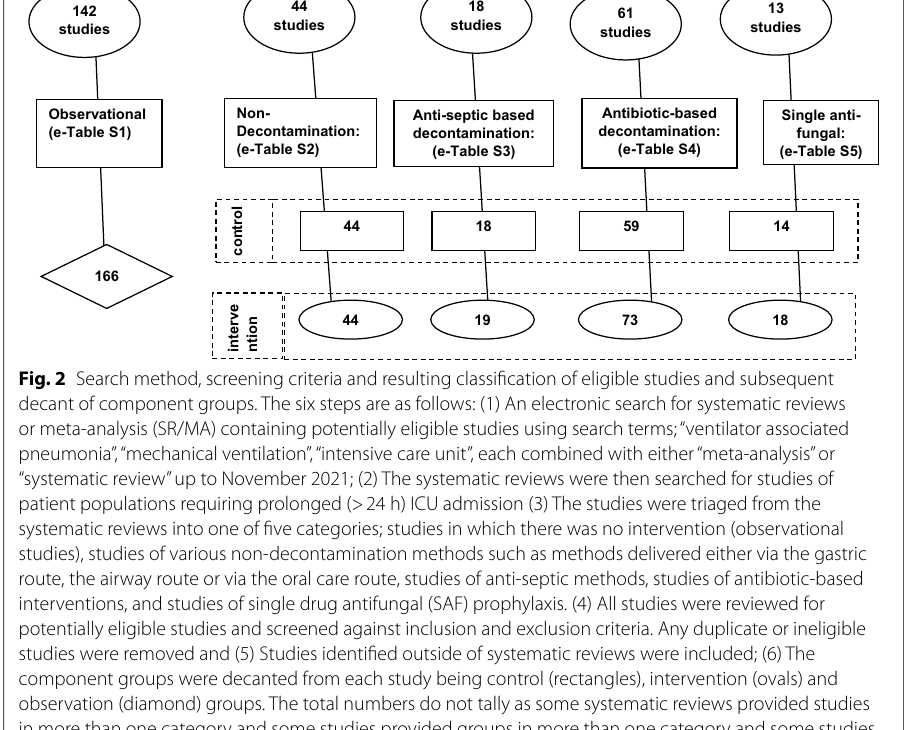
Antibiotic-based